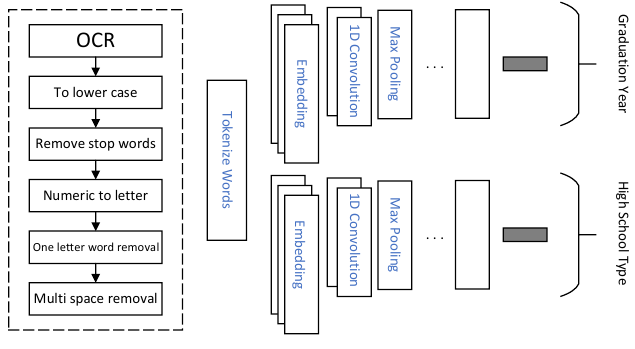
Fig. 2. Illustration of text classification